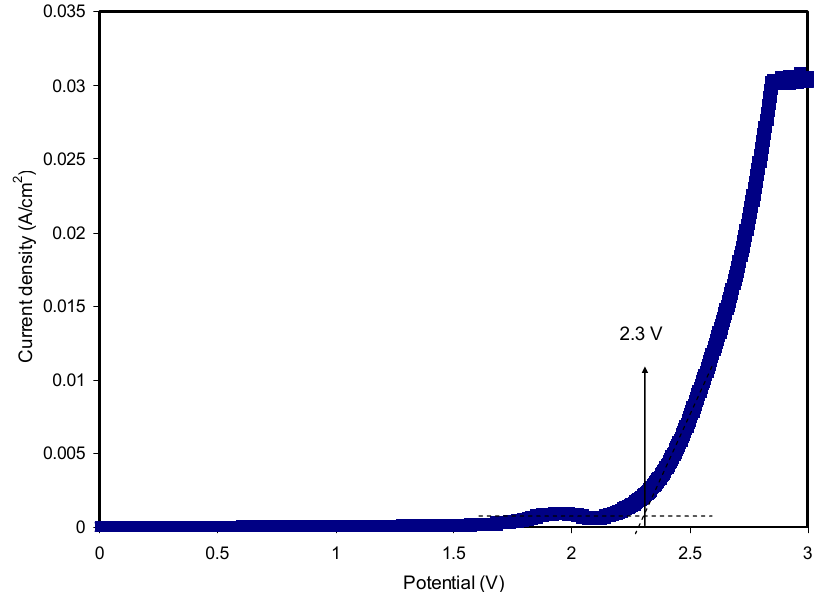
Figure 10. LSV plot for the highest conducting SPE with a scan rate of 50 mV/s.